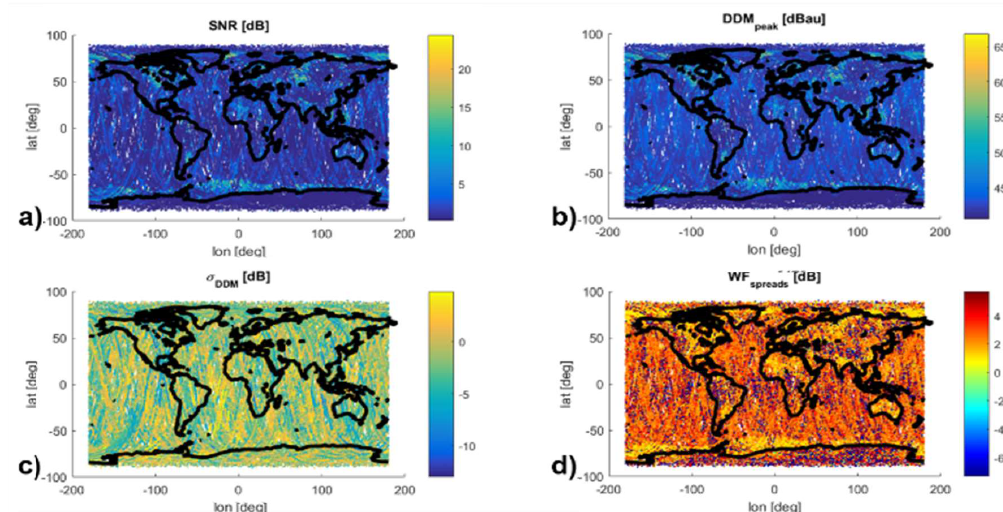
Figure 1. Sample TechDemoSat-1 (TDS-1) data: ( a ) SNR [dB] computed as the ratio of the peak of the Delay Doppler Maps (DDM) to the noise; ( b ) DDM peak; ( c ) standard deviation of the peak; and ( d ) waveform spread figure of merit.